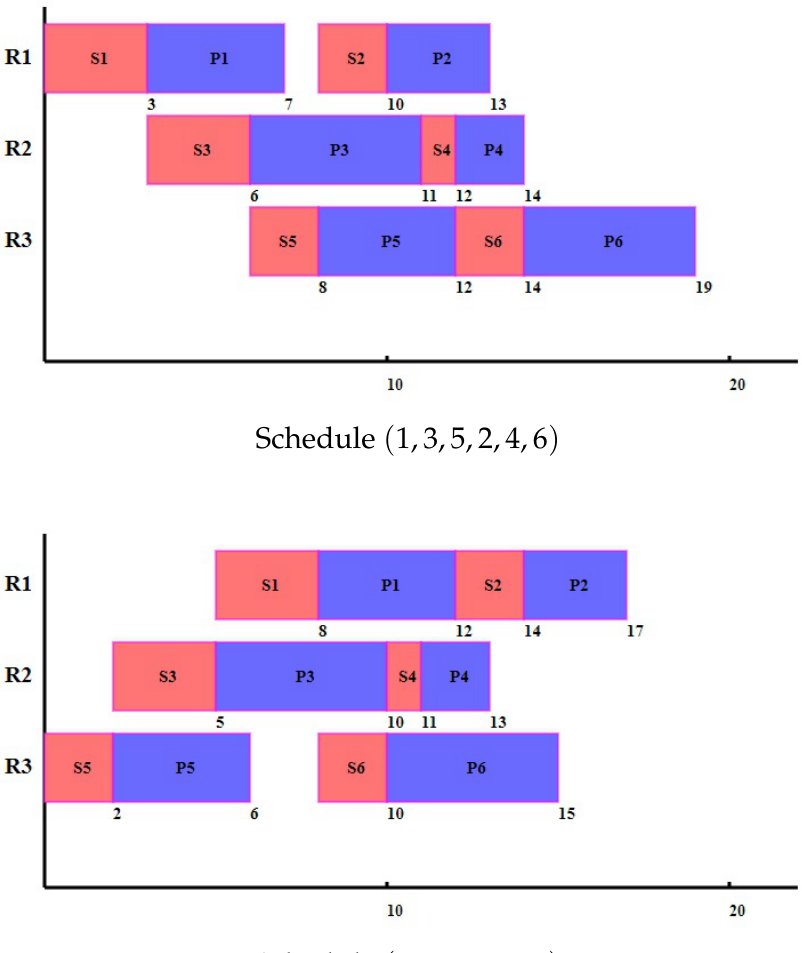
Figure 1. Two example Figure 1: Two example schedules